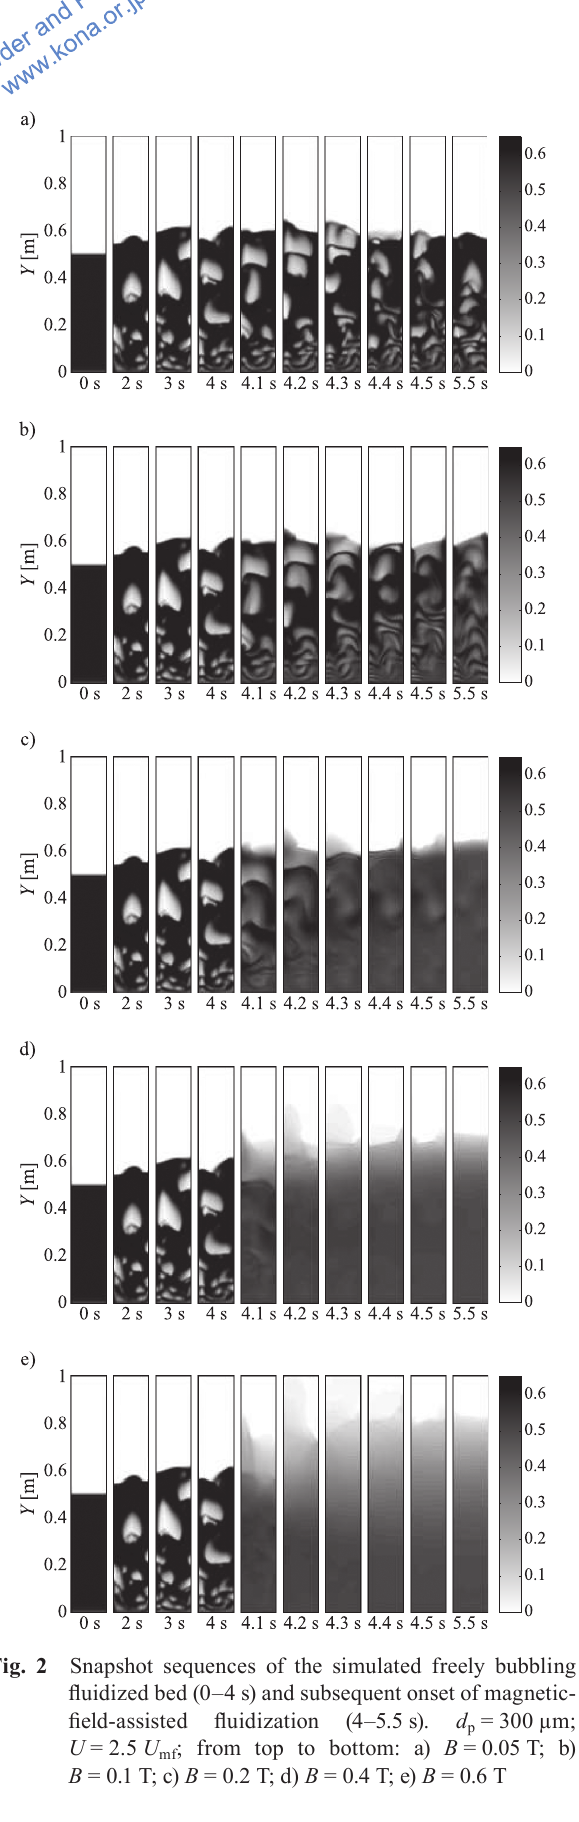
Fig. 2 Snapshot sequences of the simulated freely bubbling fluidized bed (0–4 s) and subsequent onset of magnetic- field-assisted fluidization (4–5.5 s). d p = 300 µm; U = 2.5 U mf ; from top to bottom: a) B = 0.05 T; b) B = 0.1 T; c) B = 0.2 T; d) B = 0.4 T; e) B = 0.6 T